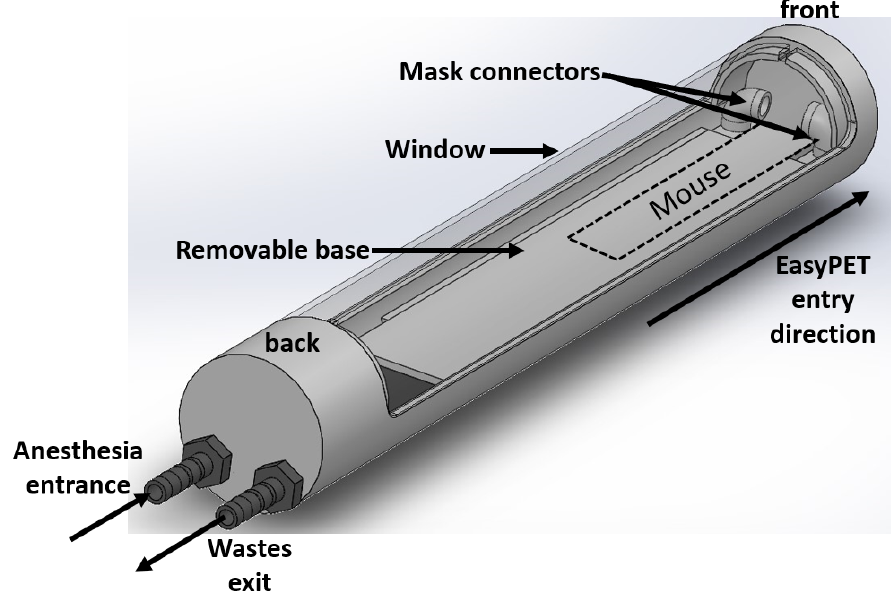
Figure 2. easyPET.3D bed prototype, with the representations of its several